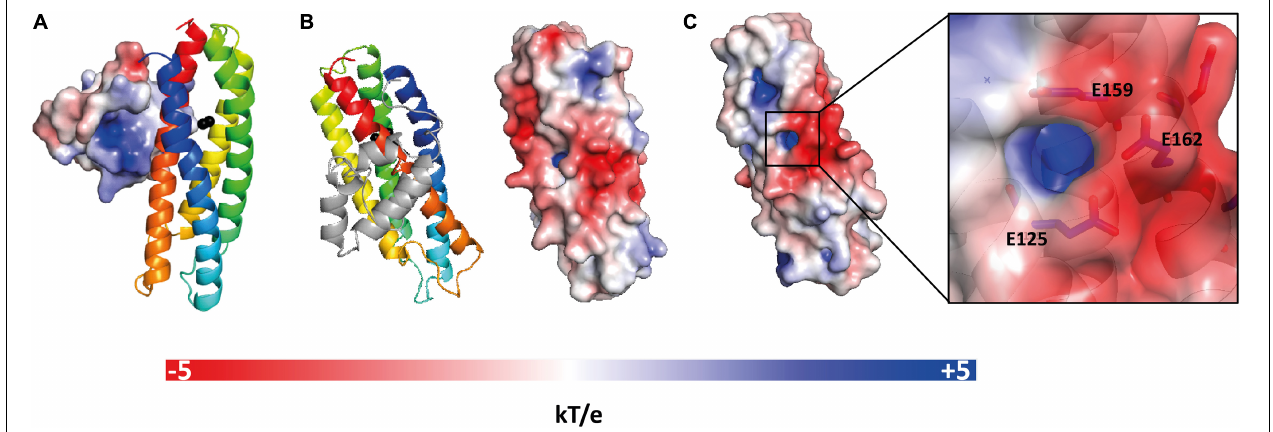
FIGURE 3 | Electrostatic potential at the molecular surface of E. coli YtfE M . (A) Electrostatic potential surface of domain A that faces domain B is positively charged. (B) View of YtfE M rotated 90 ◦ about a vertical axis from panel A , the electrostatic surface representation (right) is on the same orientation as the cartoon representation of the structure (left), without domain A. (C) Detail of the electrostatic surface (negatively charged) near the iron cavity (positively charged). The electrostatic potential at the molecular surface was obtained considering that YtfE M is loaded with Fe 3 + -Fe 2 + . The electrostatic potential surfaces range from -5 kT/e (red) to +5 kT/e (blue). Figure prepared with PyMOL (DeLano, 2020) using ABPS (Baker et al., 2001) and PDB2PQR (Dolinsky et al., 2004) server to generate the electrostatic potential surface. The charge for each metal was manually added to the PQR file, taking in consideration the oxidation state of the